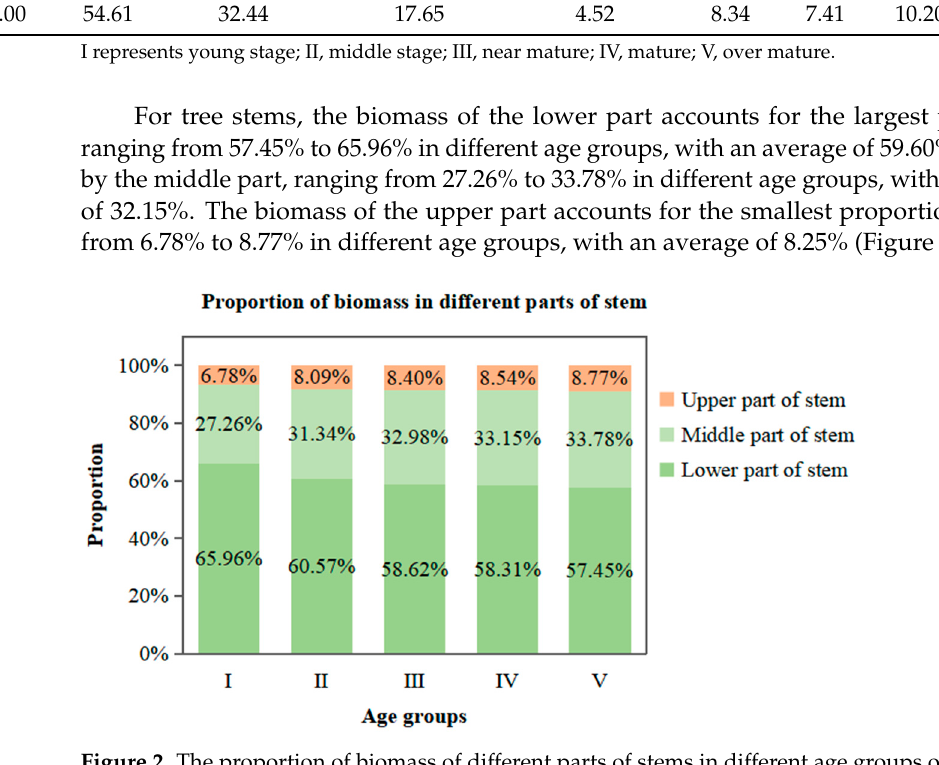
Figure 2. The proportion of biomass of different parts of stems in different age groups of Chinese fir.